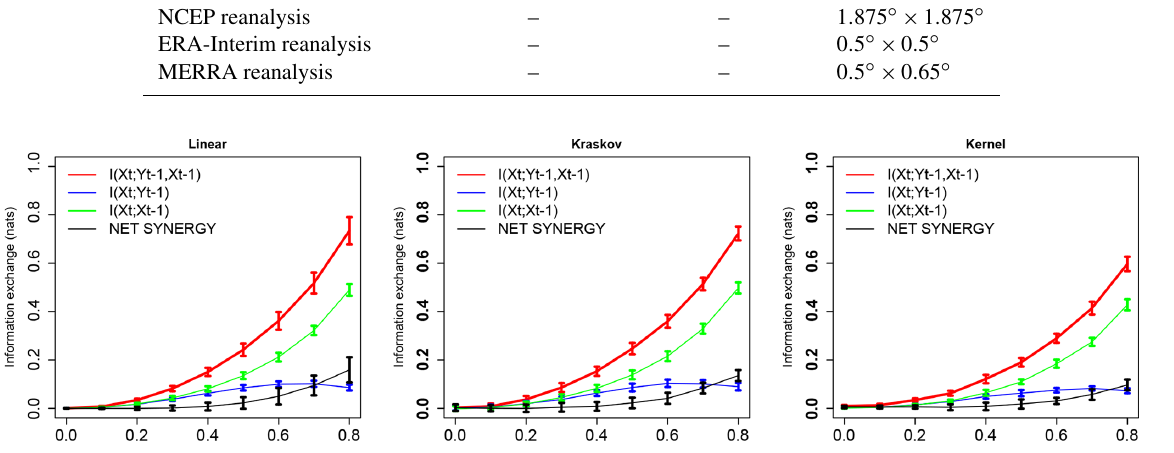
Figure 2. Information exchange in nats from two sources (red line), a single source (green and blue lines), and net synergy (black line) to the target with linear, Kraskov, and kernel estimators. The error bars represent 2 standard deviations of the 100 permuted samples.